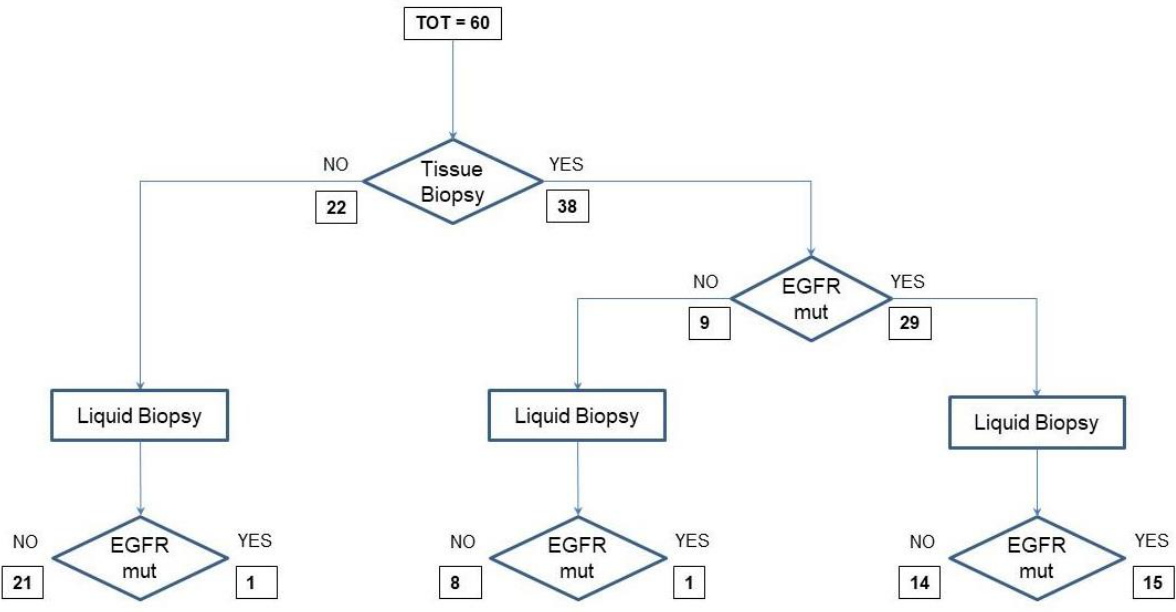
Figure 1. Samples from treatment-naïve patients and flow-chart of routine EGFR mutation analysis. There were 132 blood samples from NSCLC disease-progressive patients during TKI therapy. Seventy-six were negative for EGFR mutations in cfDNA. The other 56 were positive for activating EGFR mutations, including 14 samples positive for the exon 20 T790M EGFR mutation. This positive result for the resistance mutation led to change in therapy in 10 cases (Figure